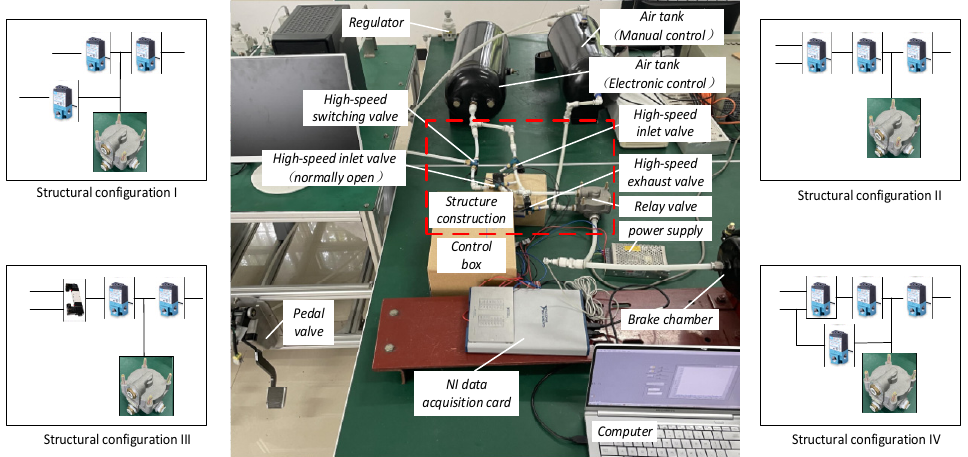
Figure 3. Test bench for the pressure regulation characteristics of the APRV of different structural configurations.